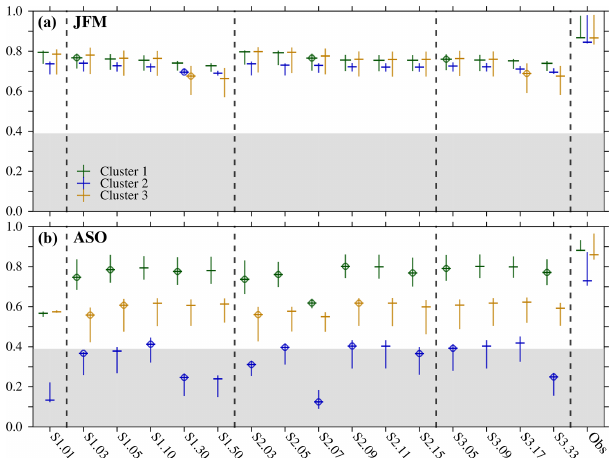
Figure 7. Spatial correlation coefficients between the simulated and observed clusters and across the three satellite observational prod- ucts (marked as Obs) of Arctic SIC in (a ) JFM and (b) ASO. For each case, the vertical line spans the maximum and minimum val- ues, and the horizontal line marks the median values; green, blue, and orange lines are for the first, second, and third clusters, re- spectively. Gray shading masks statistically nonsignificant coef- ficients below 0.39 value, which corresponds with the minimum value across all the computations that is statistically significant at the 5% level, accounting for effective degrees of freedom and spa- tial autocorrelation. A dot is plotted when the difference between the median correlation coefficient values in one discretization and the one immediately below within the same discretization type is statistically significant, based on Fisher’s z transform assuming a two-tailed 5% level. Dashed vertical lines separate between results in the simulation with one single category (S1.01), the different ITD discretizations (S1, S2, and S3), and the observations. Note the dis- cretizations S2.09 and S3.09 are the same (Fig.